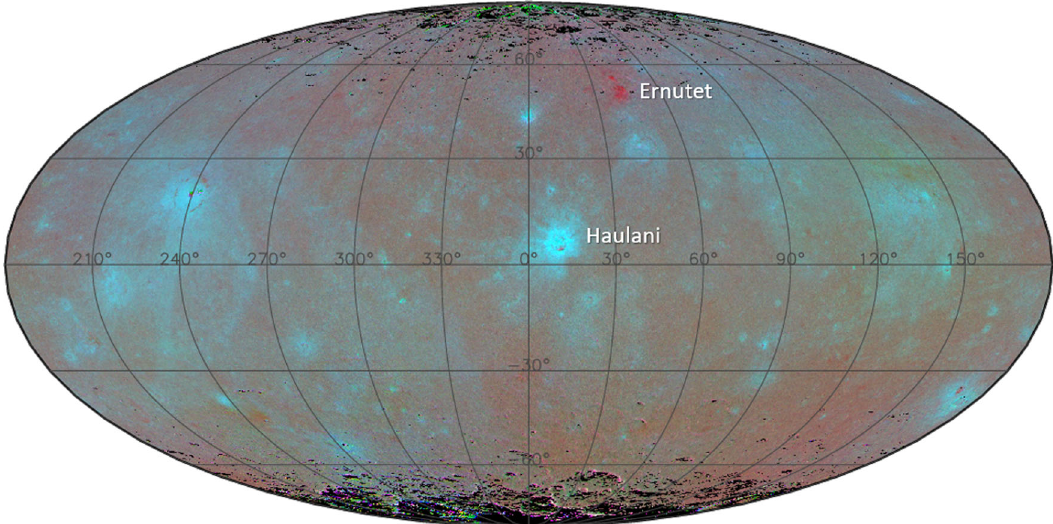
Fig. 1 Global distribution of blue material on Ceres, with longitude (horizontal) and latitude (vertical) indicated. Shown is a global false colour composite with the photometrically corrected re fl ectance ratios of 965/749, 555/749, and 438/749 nm in the RGB colour channels, respectively 4 . This colour coding scheme emphasizes variations in spectral slope, with blue and red areas having a negative and positive spectral slope, respectively. One of the bluest areas on Ceres is Haulani crater, whereas the reddest area is associated with Ernutet crater 53 . The horizontal extent of the map is 3030